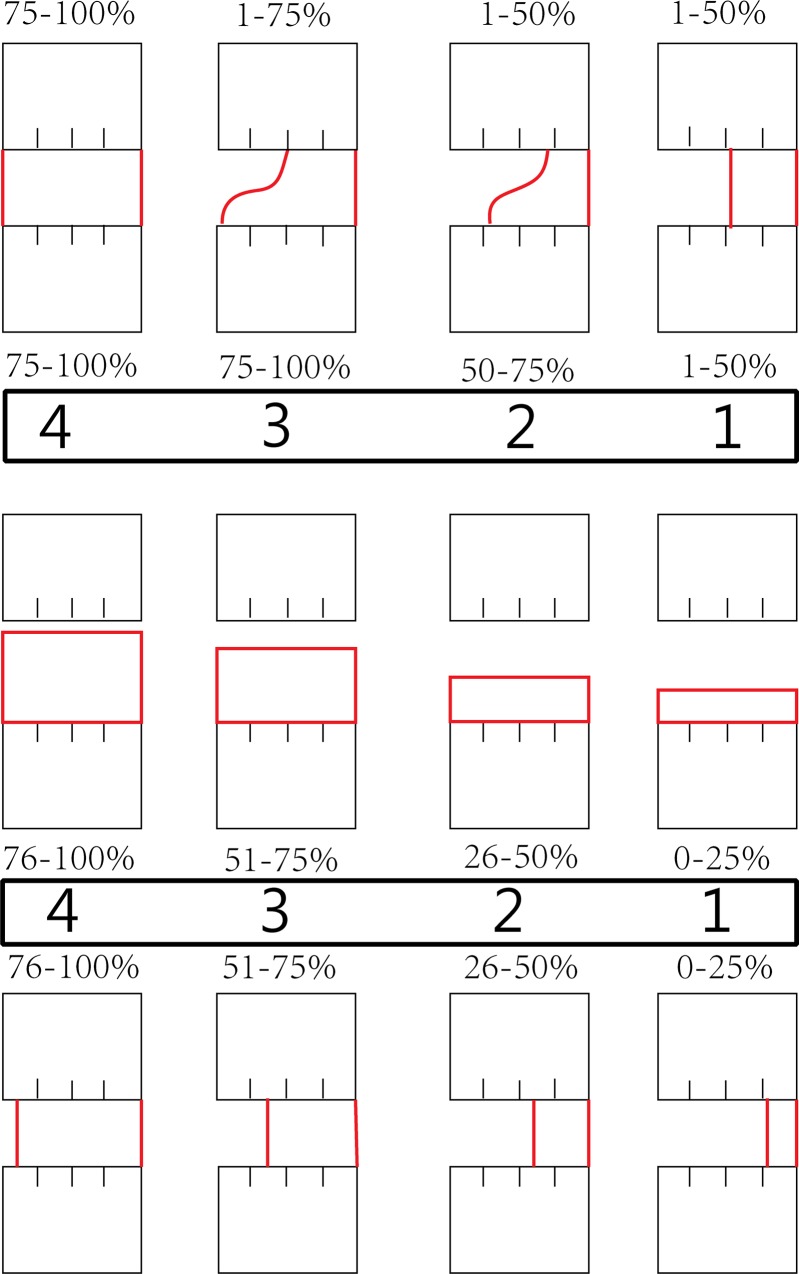
Quantitative evaluation of new bone formation in X-ray and μCT images for grades.Values refer to the percentage of the given defect border that is bridged by bone tissue of each side of the defect. A score of zero was used when no bone bridging or bone formation was found.